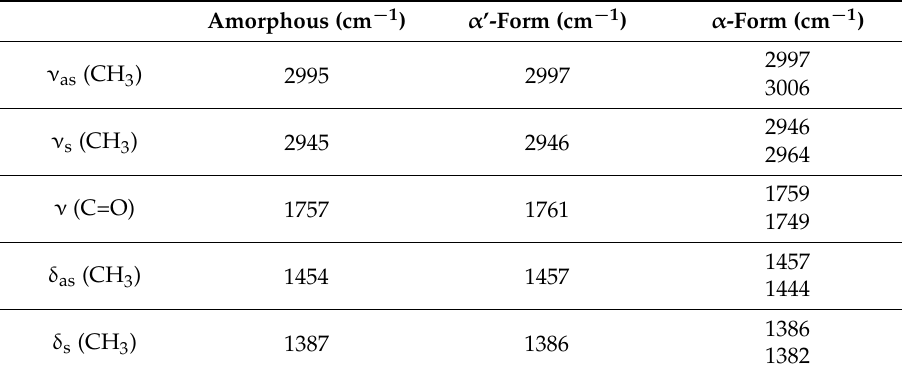
Table 3. IR frequencies of amorphous, α ’-form, and α -form PLLA